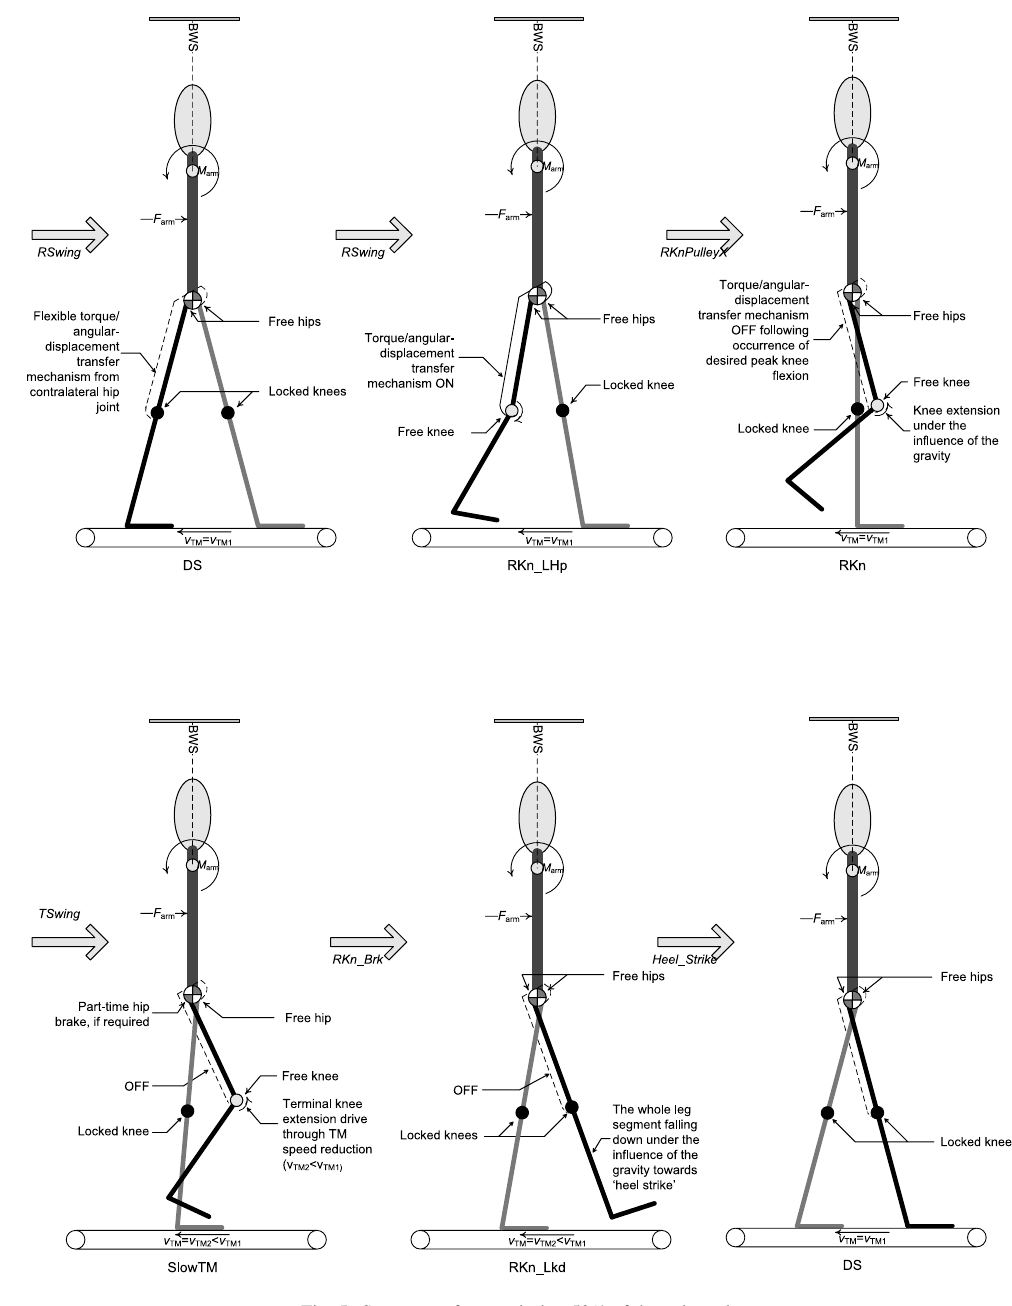
Fig. 5. Sequence of states during 50% of the gait